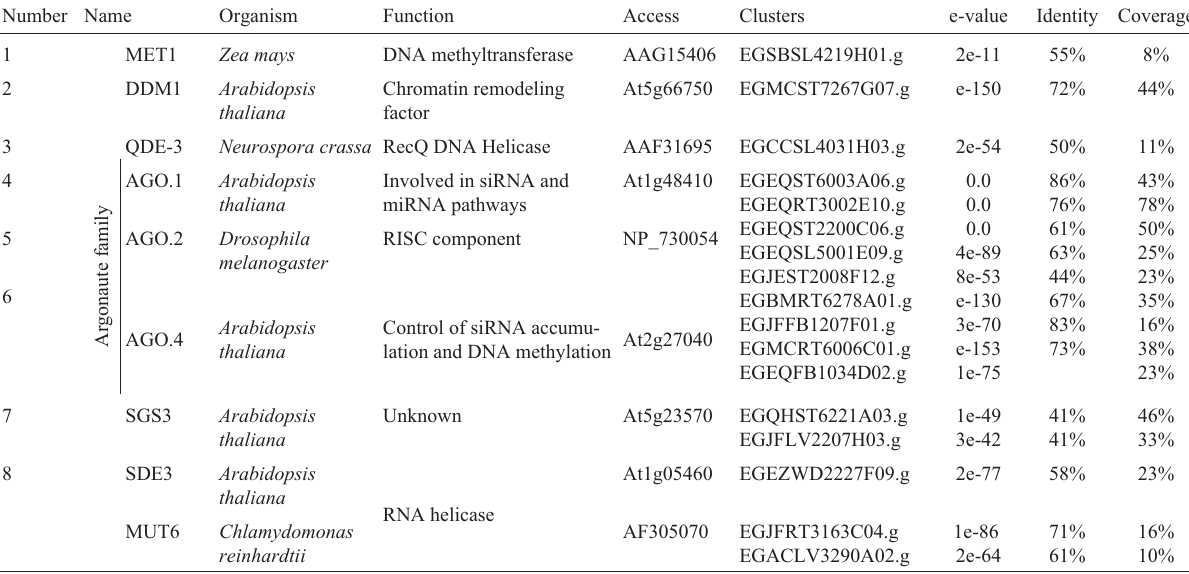
Figure 1 - Schematic representation of the molecular steps in PTGS path- way. Nuclear events at the loci of the target gene or transgene are pro- moted by MET1, DDM1 and QDE3 (a RecQ DNA helicase). PTGS is triggeredbylongdsRNAmoleculesthatareconvertedbytheribonuclease III Dicer (or Dicer-like enzymes) into small interfering dsRNAs of 21-23 nucleotides (siRNA). One strand of siRNA is transferred from DCL to RISC, thus directing target RNA cleavage. Unprotected generated ends are targets for exoribonucleases (Rnase D and AtXRN4). A siRNA- primed RNA-dependent RNA polymerase (RdRP) synthesizes new dsRNAmoleculesfromtargetRNAthusperpetuatingtheprocess.Sid-1is a transmembrane protein required for systemic signaling in C. elegans . Table 1 - PTGS-related proteins and homologues identified in Eucalyptus